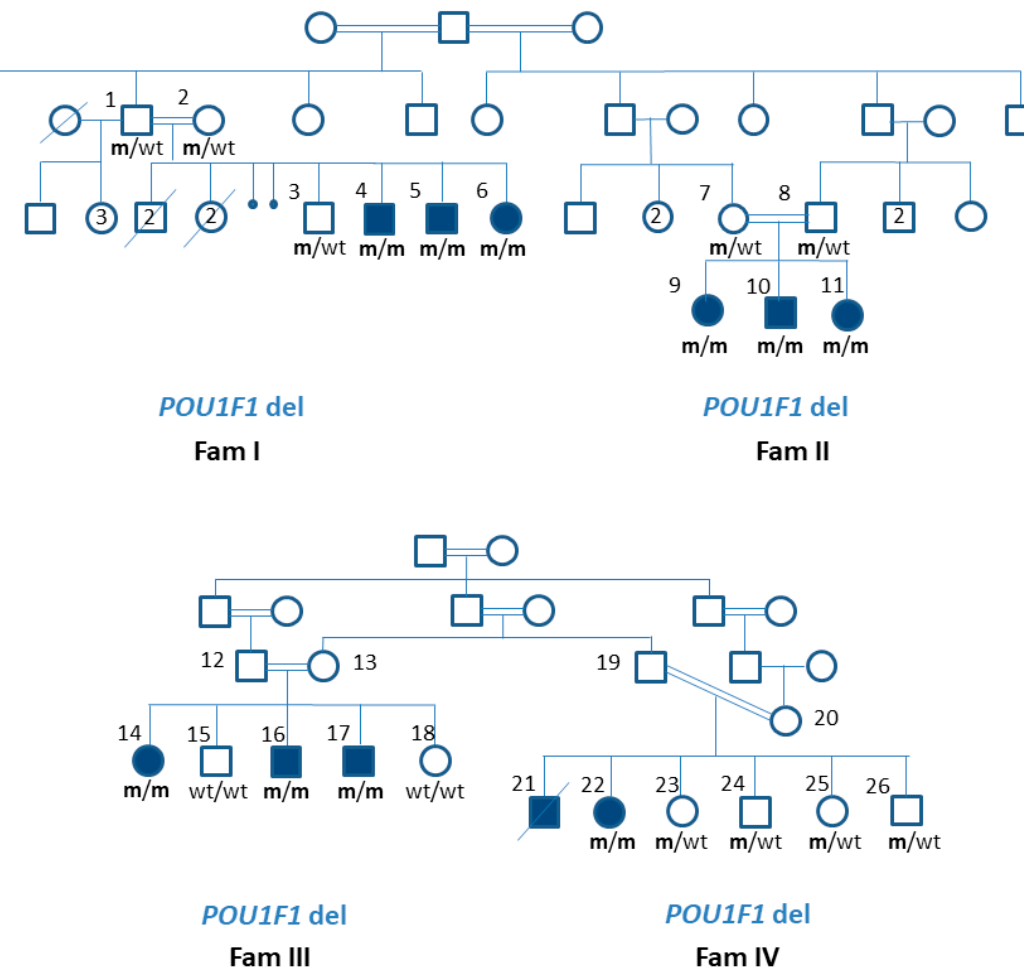
Figure 1. Pedigrees and gene variant status in families with combined pituitary hormone deficiencies.